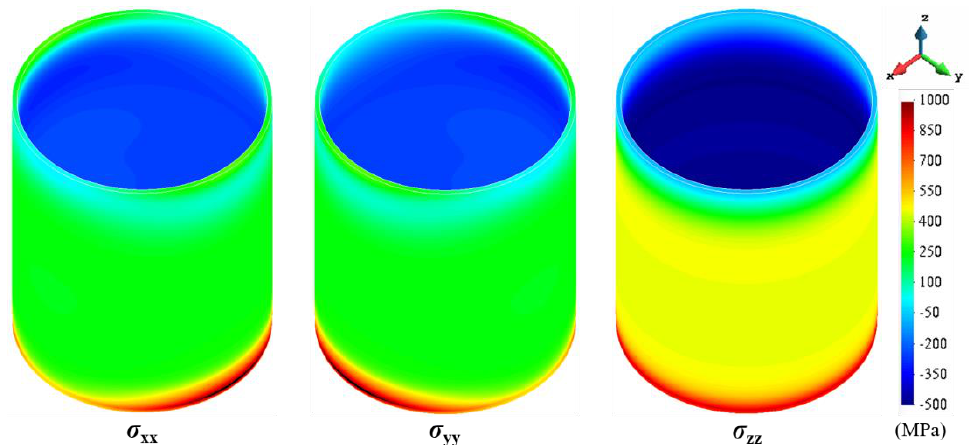
Figure 13. Comparison between the ( a ) experimental and ( b ) simulated displacement distributions of the hollow cylindrical part. ( c ) The deformation distribution along the line AB located at the cen- ter of the inner surfaces of the build.